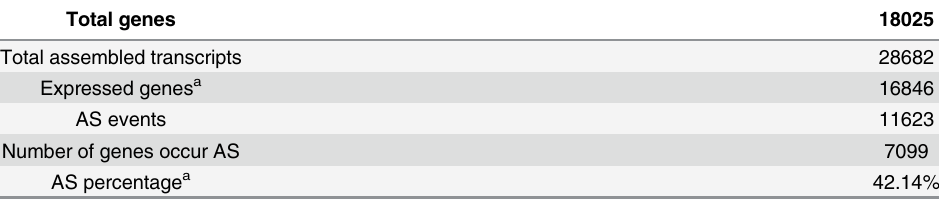
Table 1. Statistics of genes indentified in RNA-seq